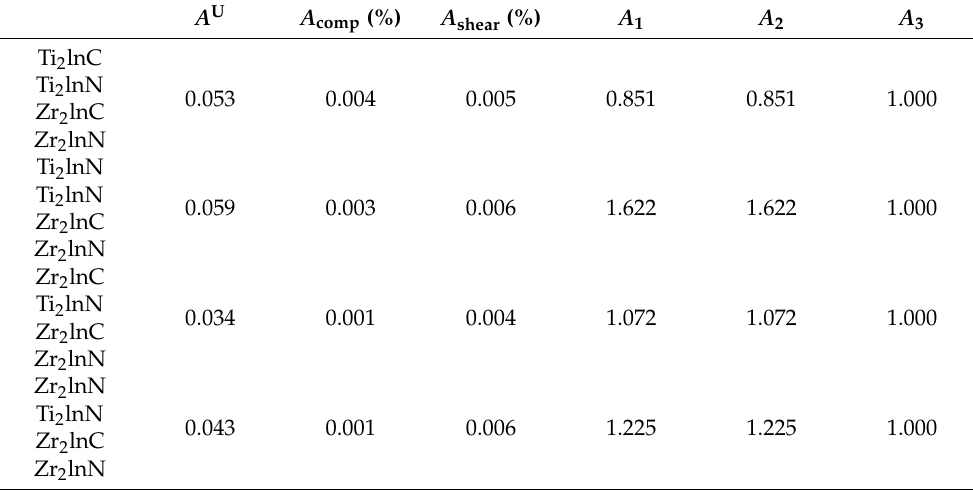
Table 4. Calculated elastic anisotropic indexes ( A U , A comp , A shear , A 1 , A 2 , A 3 ) of M 2 InX (M = Ti, Zr and X = C, N) of MAX